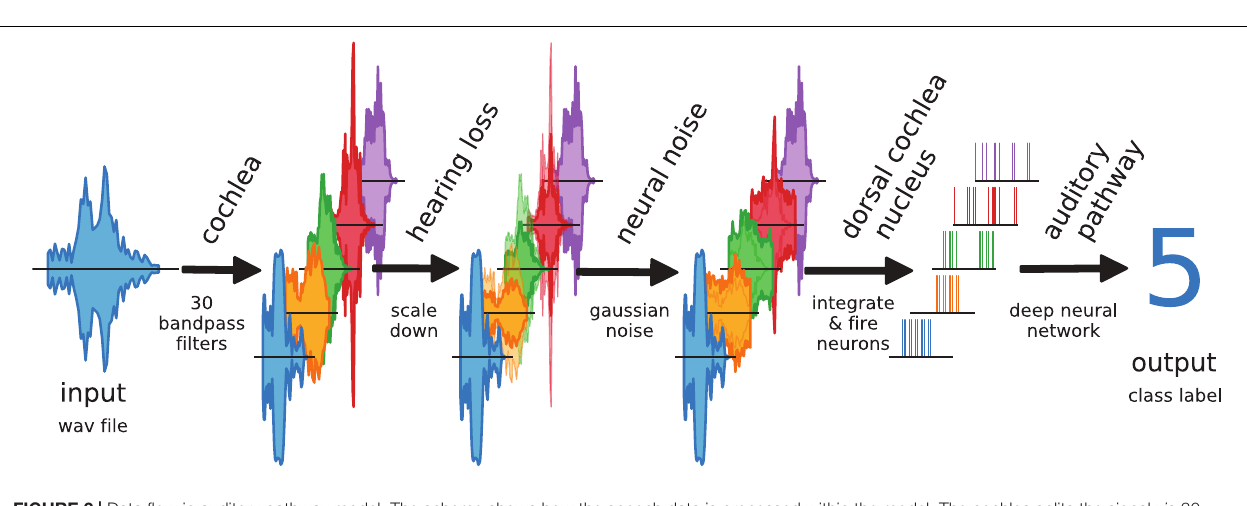
FIGURE 2 | Data flow in auditory pathway model. The scheme shows how the speech data is processed within the model. The cochlea splits the signal via 30 bandpass filters. The bandpass filtered data is scaled down to simulate a hearing loss. The hearing loss affects only channels within the speech relevant frequency range (orange, green, red). The other frequency channels are unchanged. Neural noise is added to investigate the effect of stochastic resonance (only in hearing impaired channels). The DCN is simulated as 30 LIF neurons. Each LIF neuron represents a complete biological neuron population. The spike data is down-sampled and fed to the deep neural